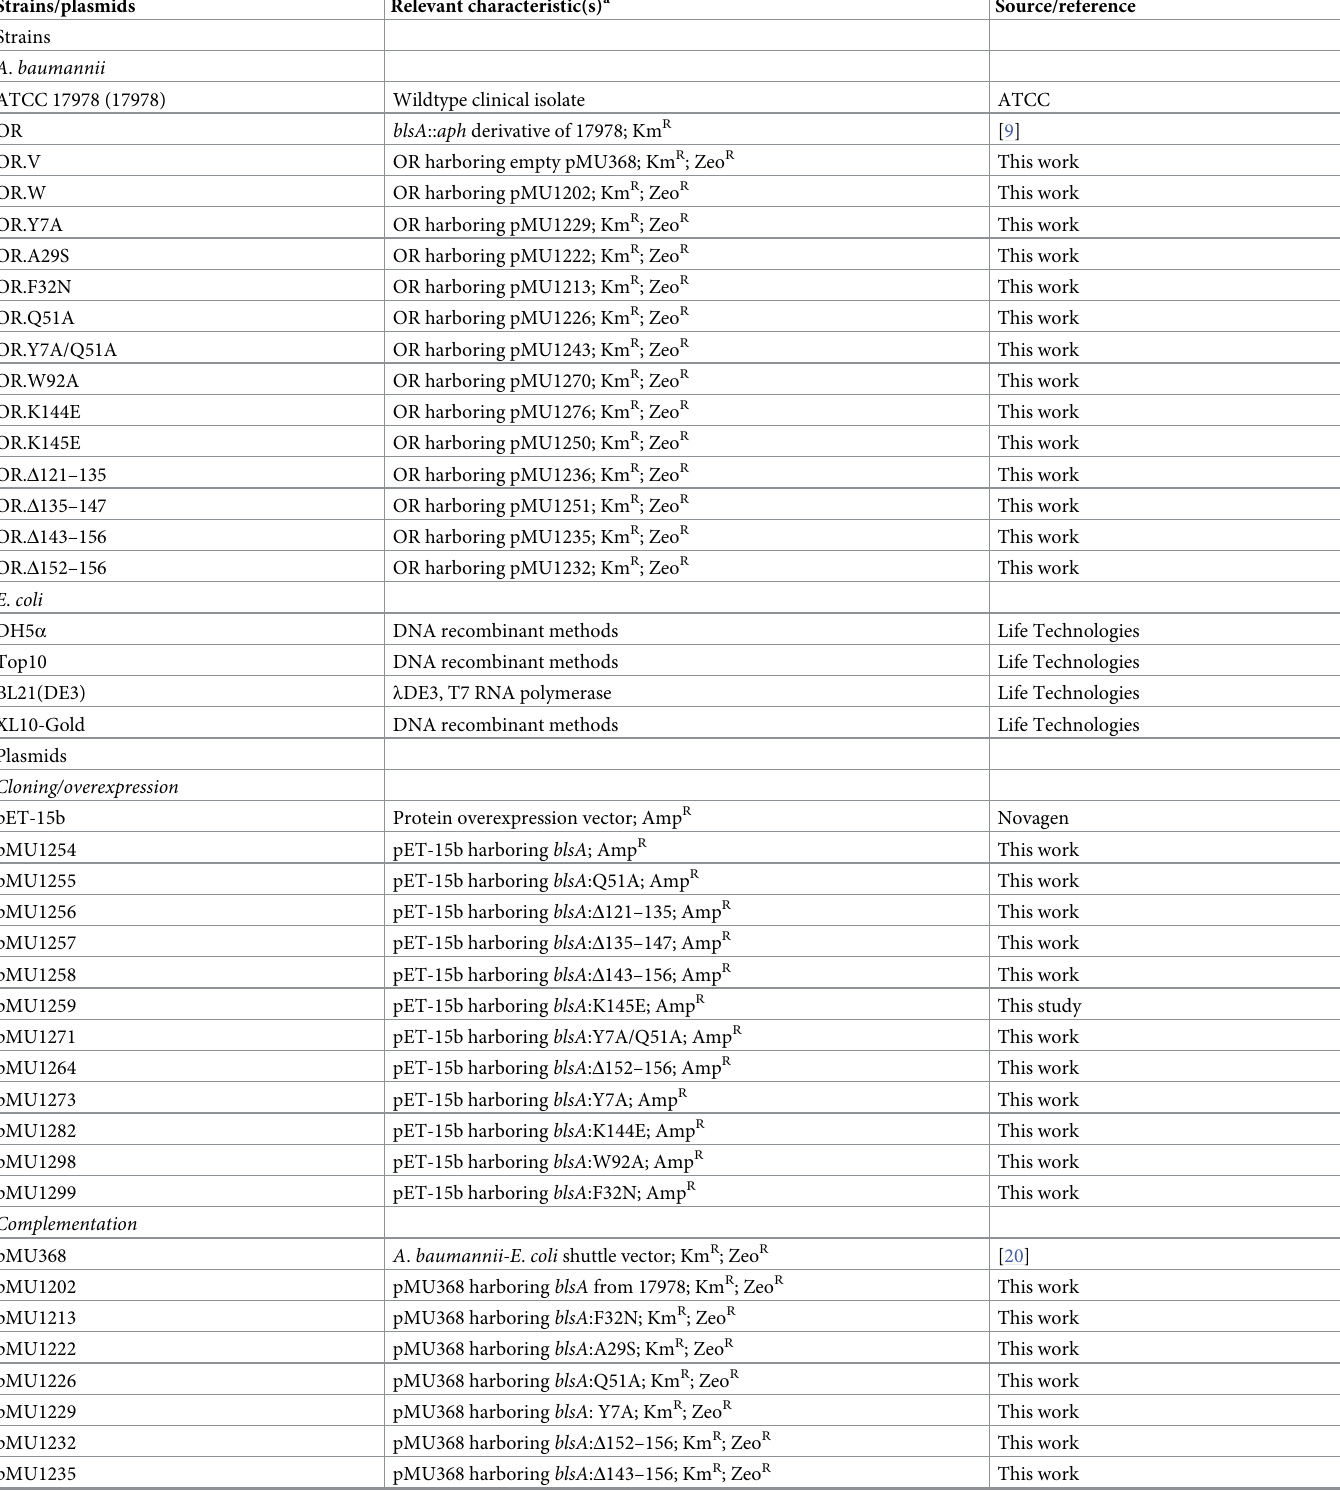
Table 1. Bacterial strains and plasmids used in this